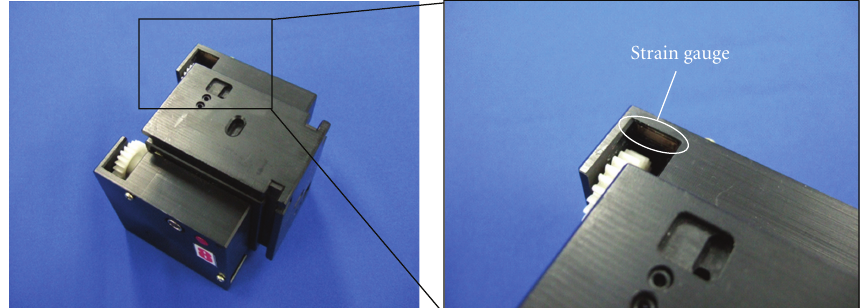
Figure 5: Position of strain gauge sensor.